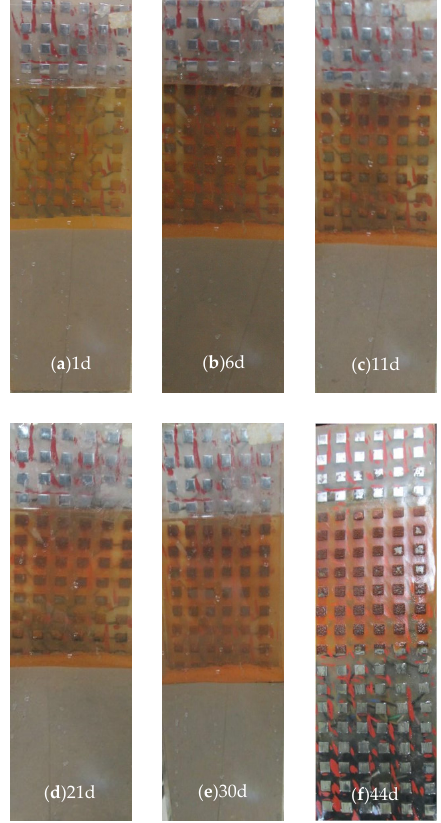
Figure 5. Morphology of the WBE surface immersed for 1 d ( a ), 6 d ( b ), 11 d ( c ), 21 d ( d ), 30d ( e ) and 44 d ( f ).